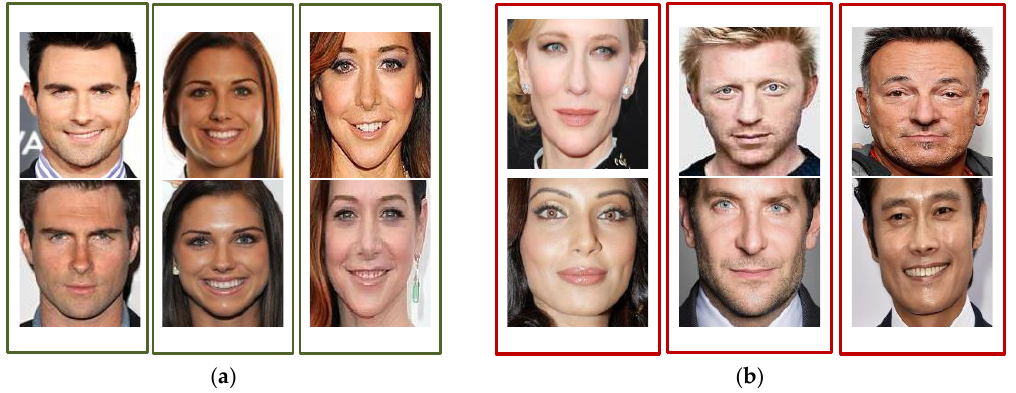
Figure 12. Test protocol for Celebrities in Frontal Profile dataset frontal-frontal(CFP_ff) mode. ( a ) Face verification for the same objects. ( b ) Face verification for different objects.